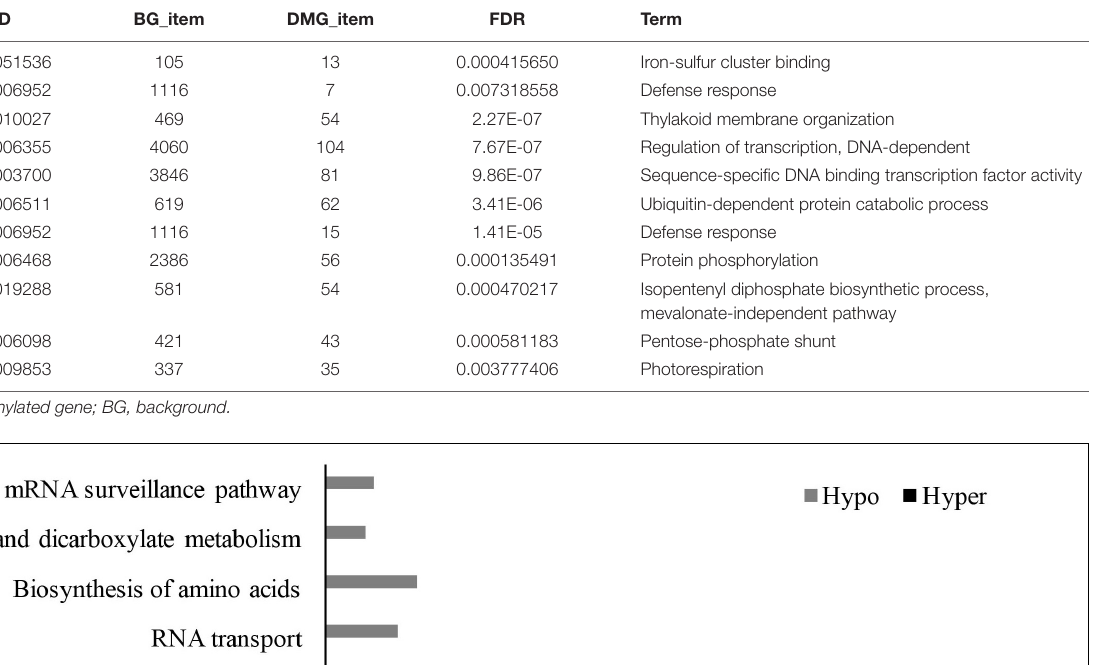
TABLE 4 | Significant GO terms of hyper- and hypo-DMGs between the WT and the cco mutant.